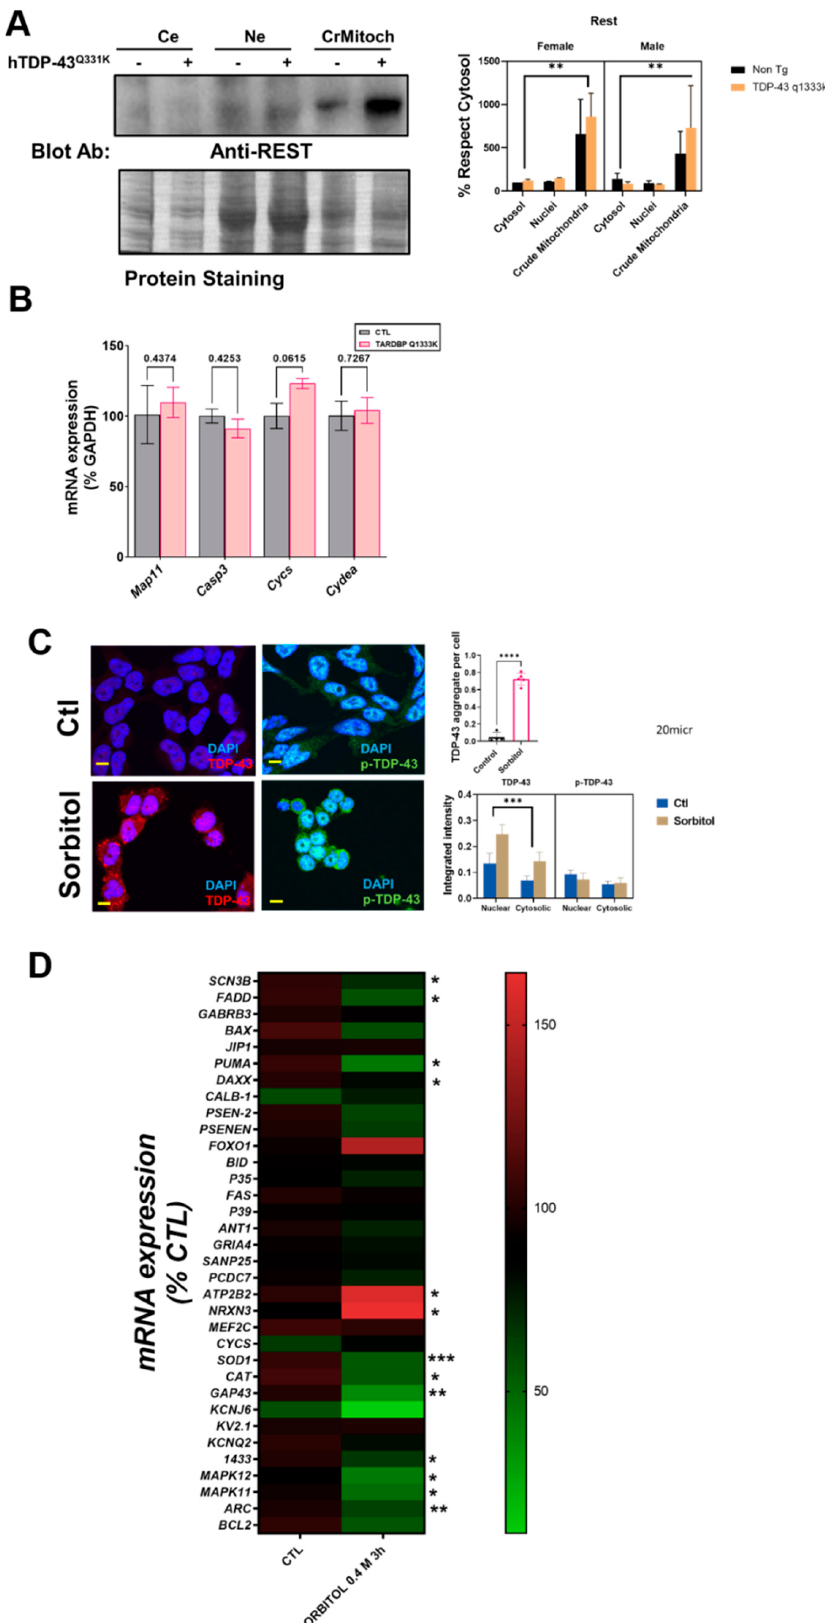
Figure 3. Cell stress-induced mislocalization of TDP-43 is associated with changes in REST-regulated genes. ( A ) Shows representative Western blots from brain lysates, indicating that REST is lo- calized within crude mitochondria (CrMitoch), in comparison with enriched nuclei (Ne) or cytosolic